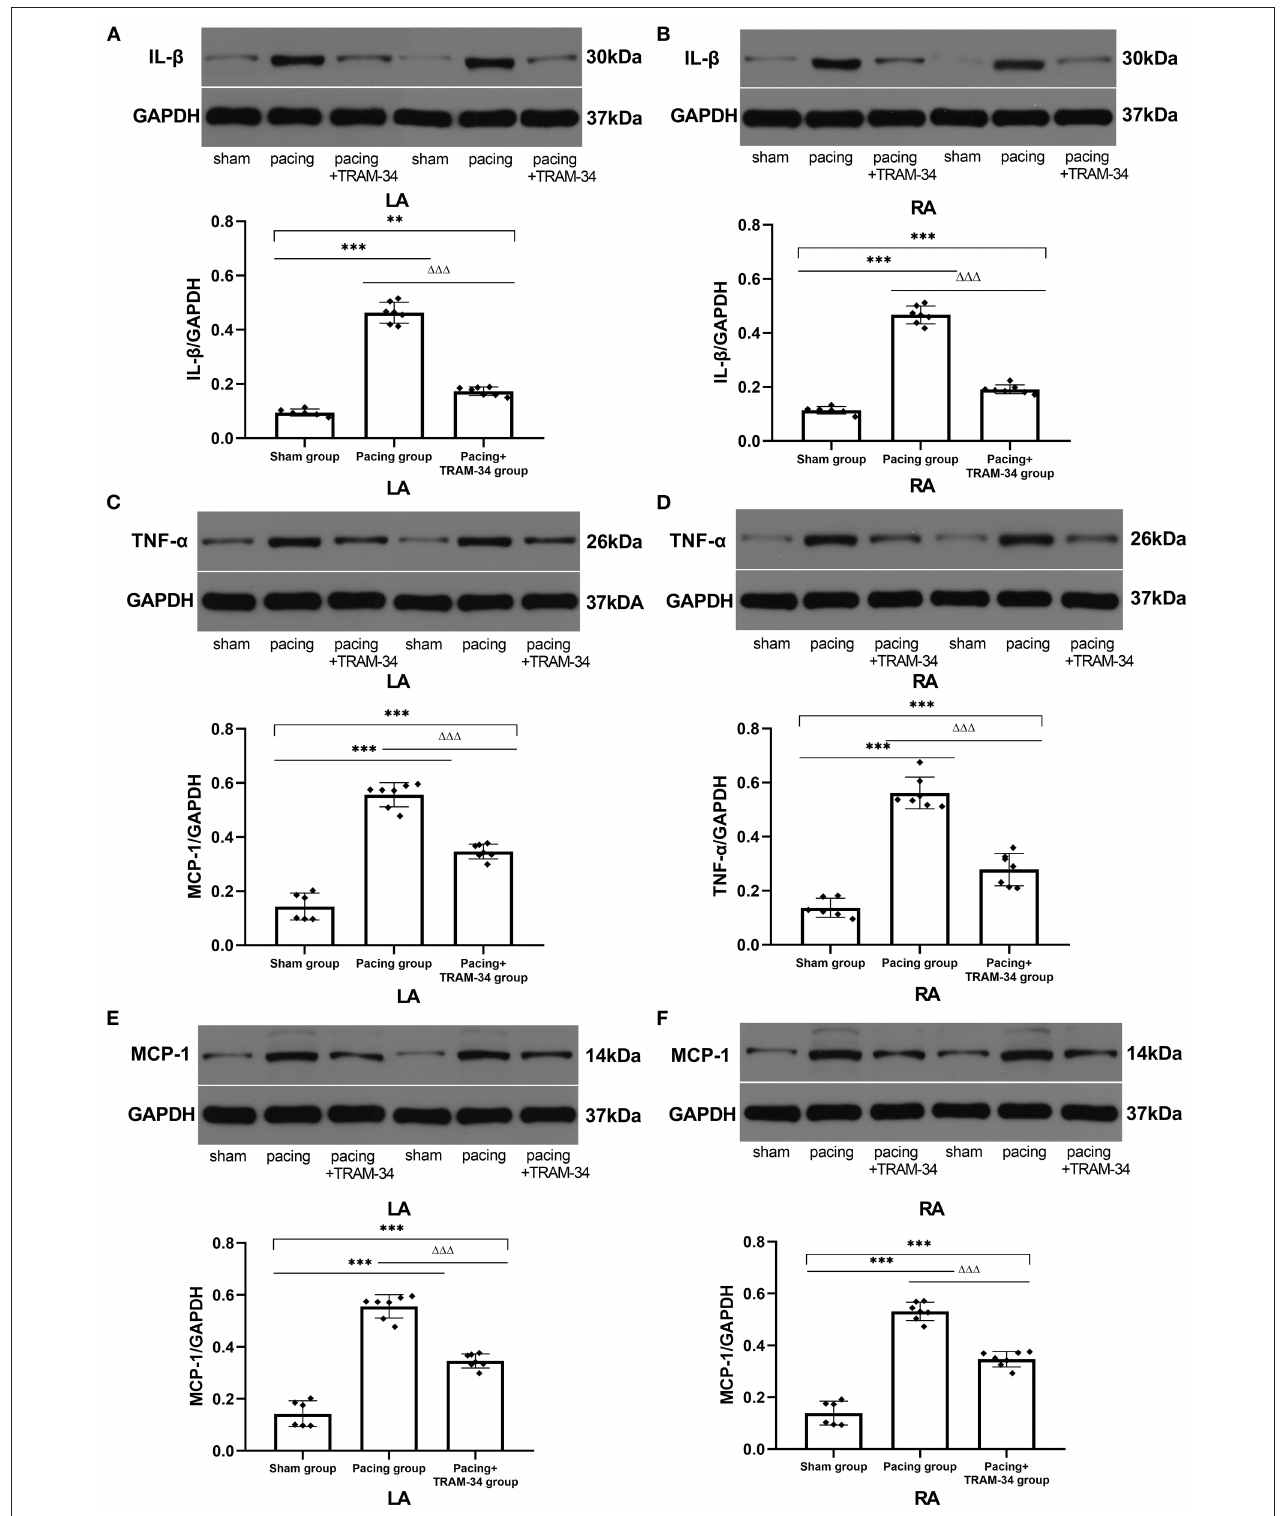
FIGURE 3 | Expression of IL-1 β , TNF- α , and MCP-1 in all groups. (A–F) Levels of IL-1 β , TNF- α , and MCP-1 in both the LA and RA were markedly higher in the pacing group compared with the sham or pacing + TRAM-34 groups. The levels of IL-1 β , TNF- α , and MCP-1 in both the LA and RA were higher in the pacing + TRAM-34 group than in the sham group. P ** < 0.01 vs. the sham group, P *** < 0.001 vs. the sham group. P 111 < 0.001 vs. the pacing group. In our experiment, the same GAPDH was used for TNF- α , MCP-1, and the same GAPDH was used for IL- β , p38, c-Fos. IL-1 β , interleukin-1 beta; TNF- α , tumor necrosis factor-alpha; MCP-1, monocyte chemotactic protein 1; LA, left atrium; RA, right